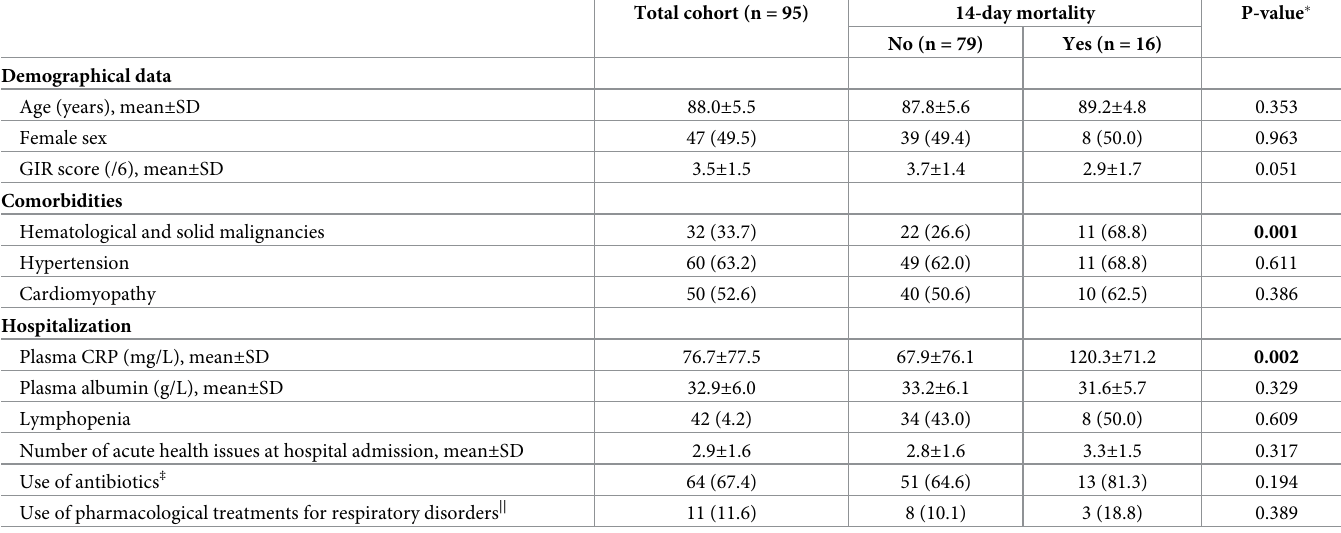
Table 1. Characteristics and comparison of COVID-19 geriatric patients separated into two groups according to 14-day mortality (n = 95). Total cohort (n =